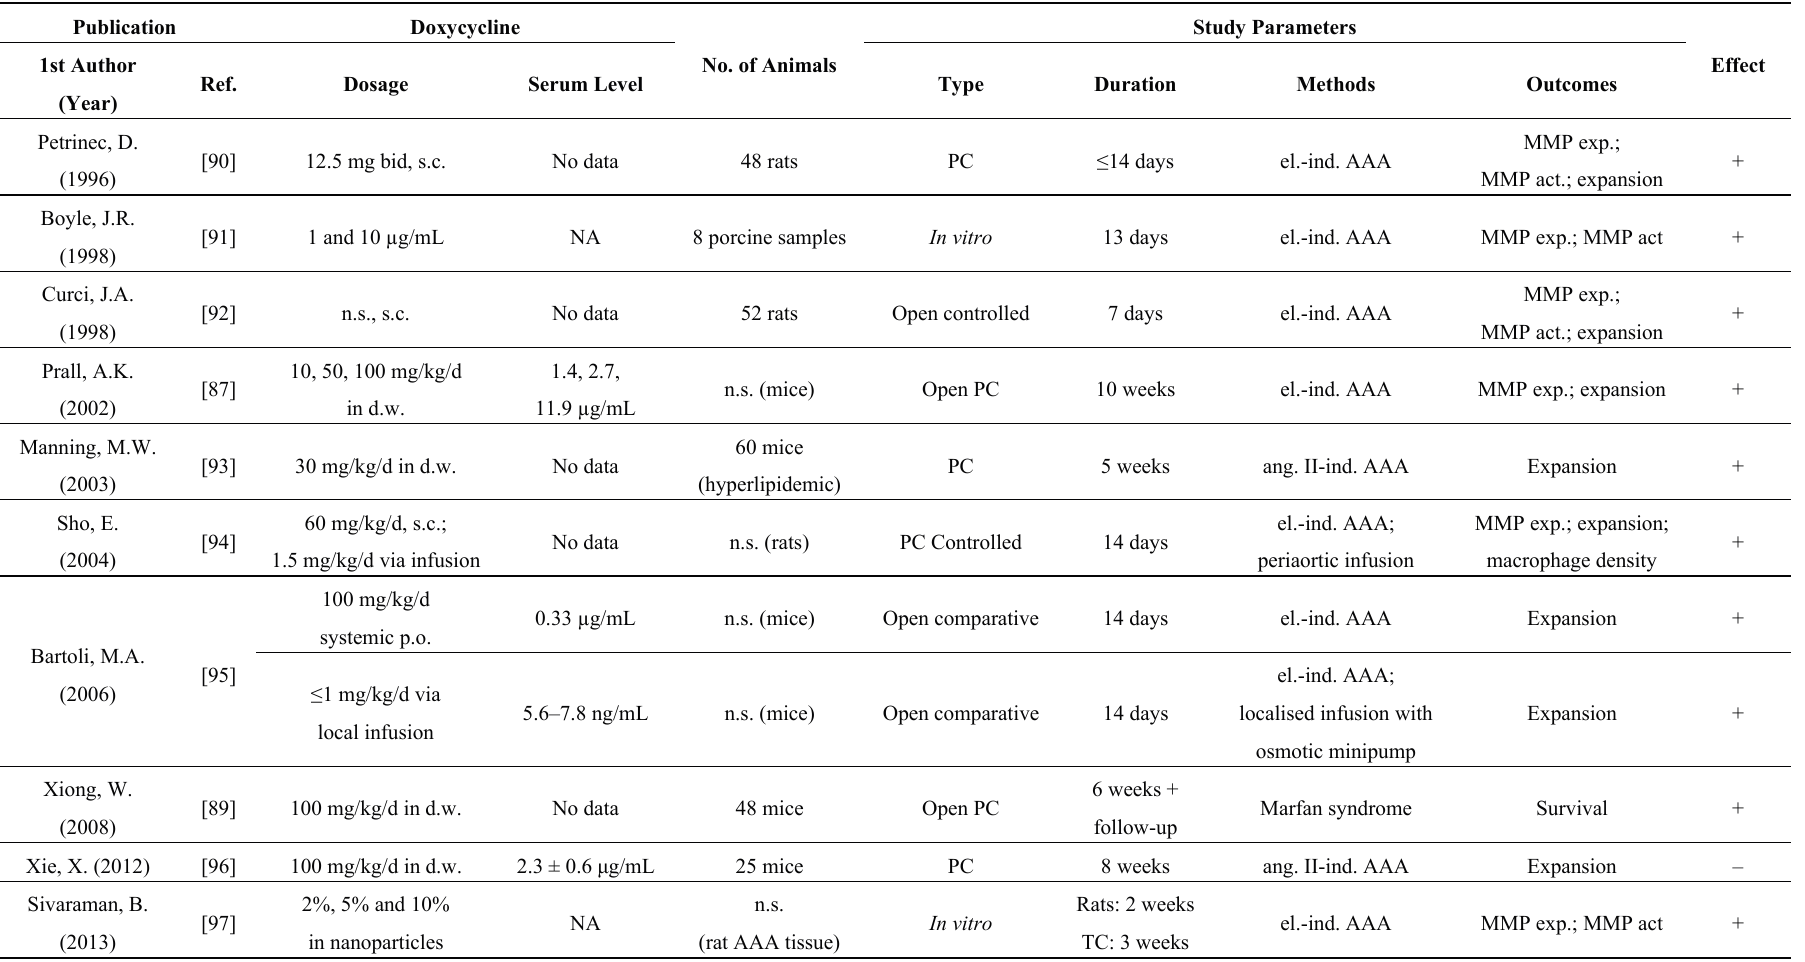
Table 2. Effect of doxycycline in studies of AAA animal